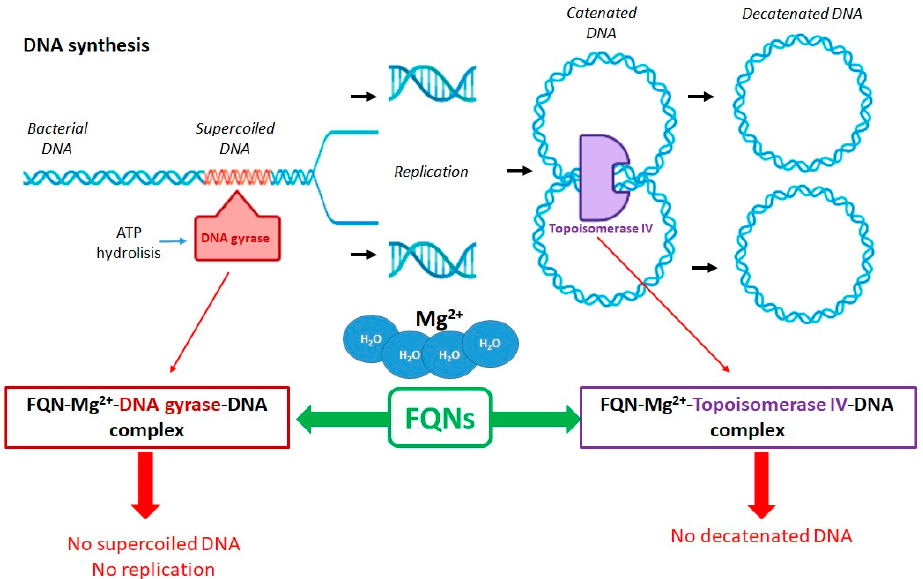
Figure 3. Role of DNA gyrase and Topoisomerase IV in the FQNs’ mechanism of action (adapted with permission from Ref. [25]).